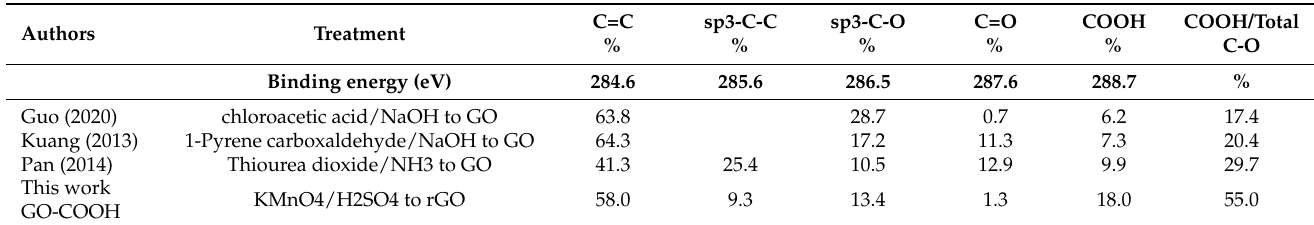
Table 2. Comparison of XPS C1s deconvolution areas (at fixed binding energies) of GO-COOH and other carboxyl graphene oxides reported in the literature. The last column of COOH/total C-O is the ratio of COOH area divided by the sum of the areas corresponding to C-O bonds